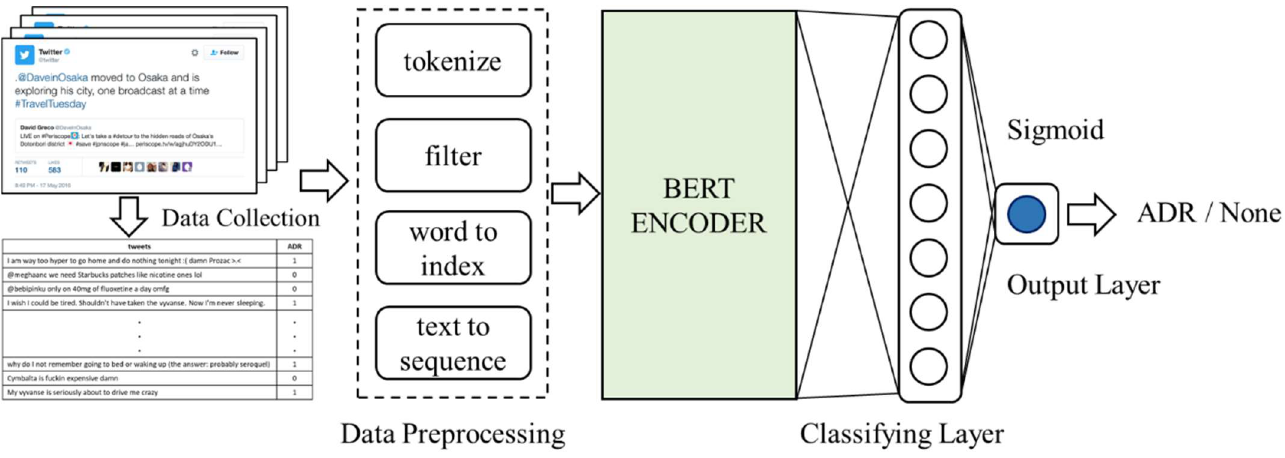
Figure 1. The proposed network architecture.